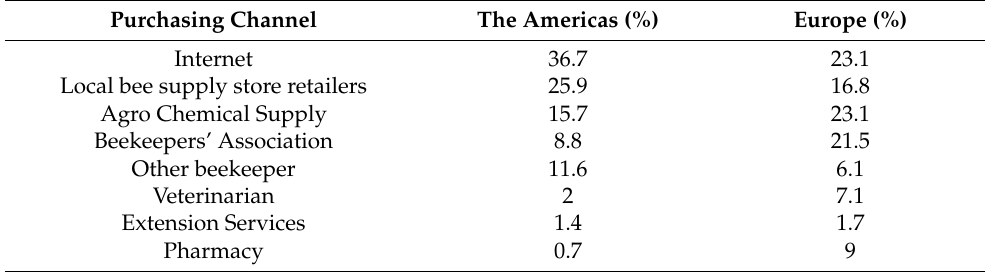
Table 3. Where the American and European beekeepers purchase medicines against